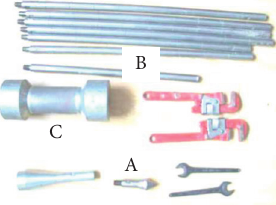
Figure 1: Composition of the simple penetrometer. A: penetrator, B: sounding rod, and C: piercing